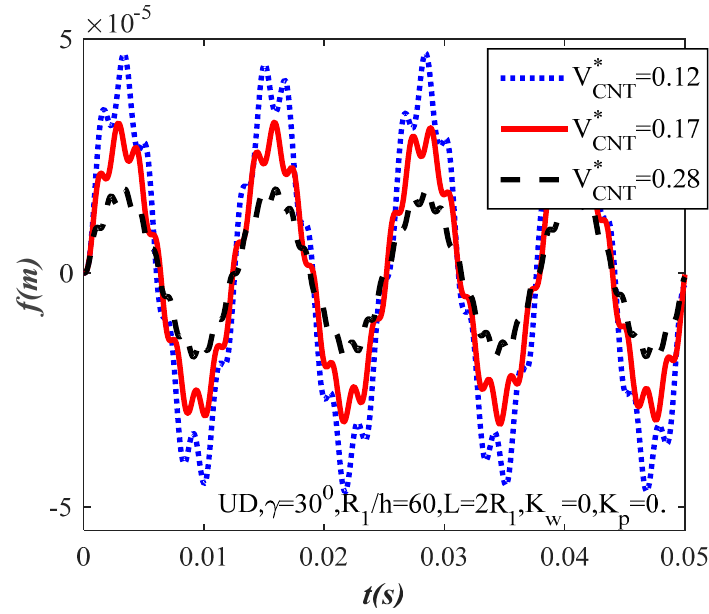
Figure 3. Effect of CNT volume fraction of fibers on the dynamic response of the CNTRC truncated conical shells with uniform distribution type.